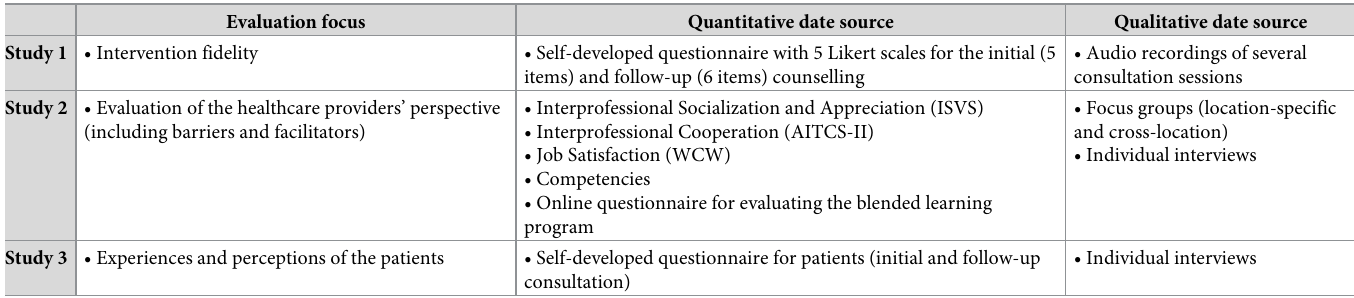
Table 1. Overview of the three studies of process